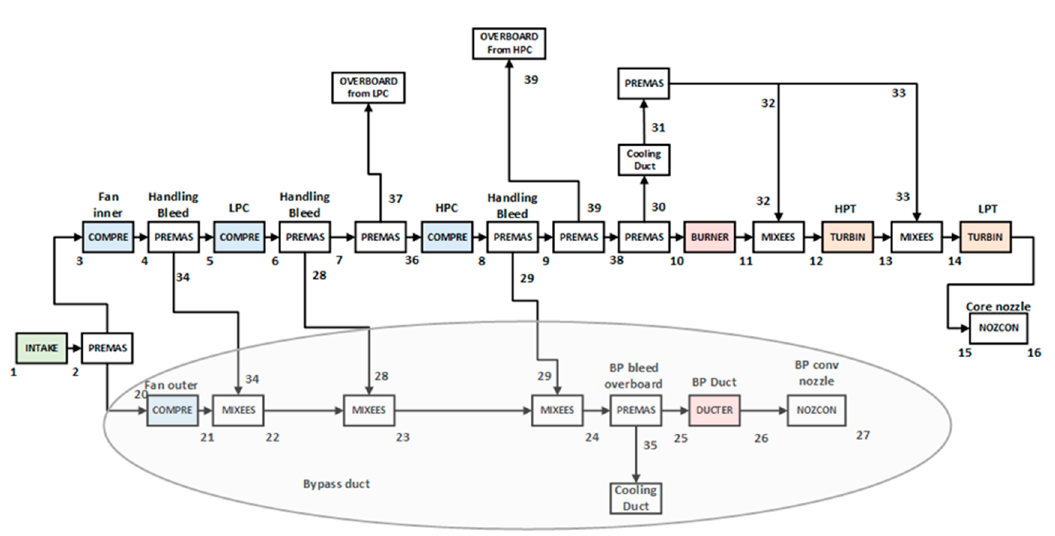
Figure A1. Engine model drawing (grey area: bypass duct).